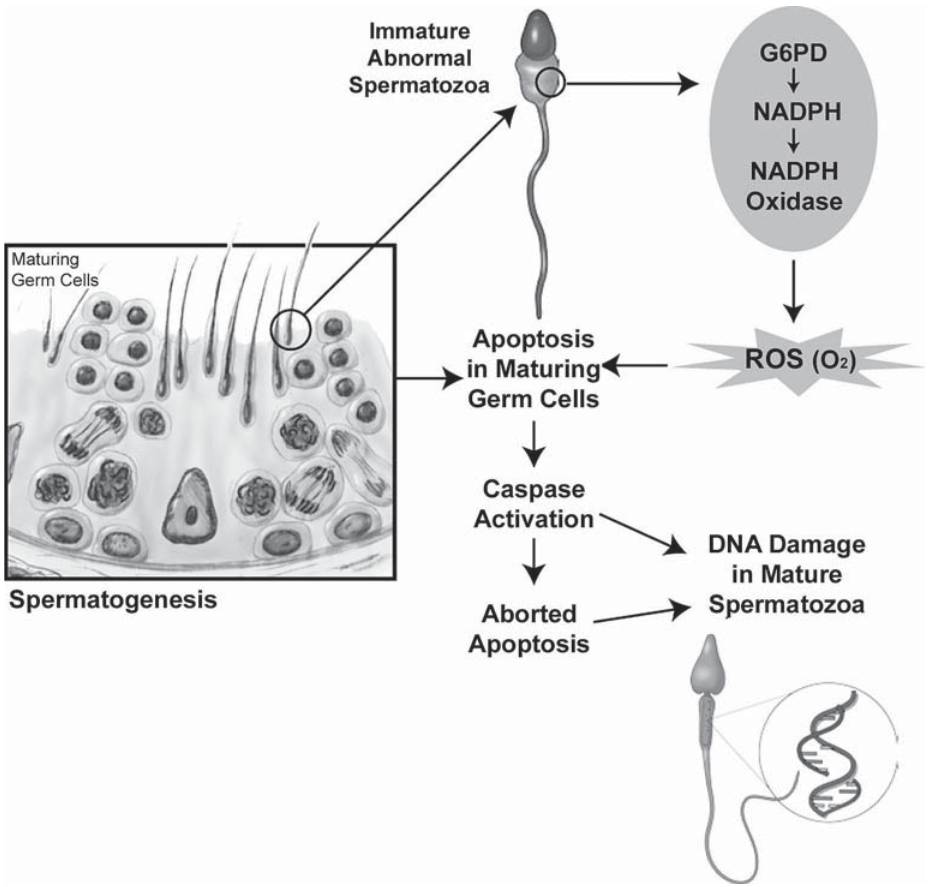
Figure 2 – Mechanistic pathway showing sperm DNA damage due to oxidative